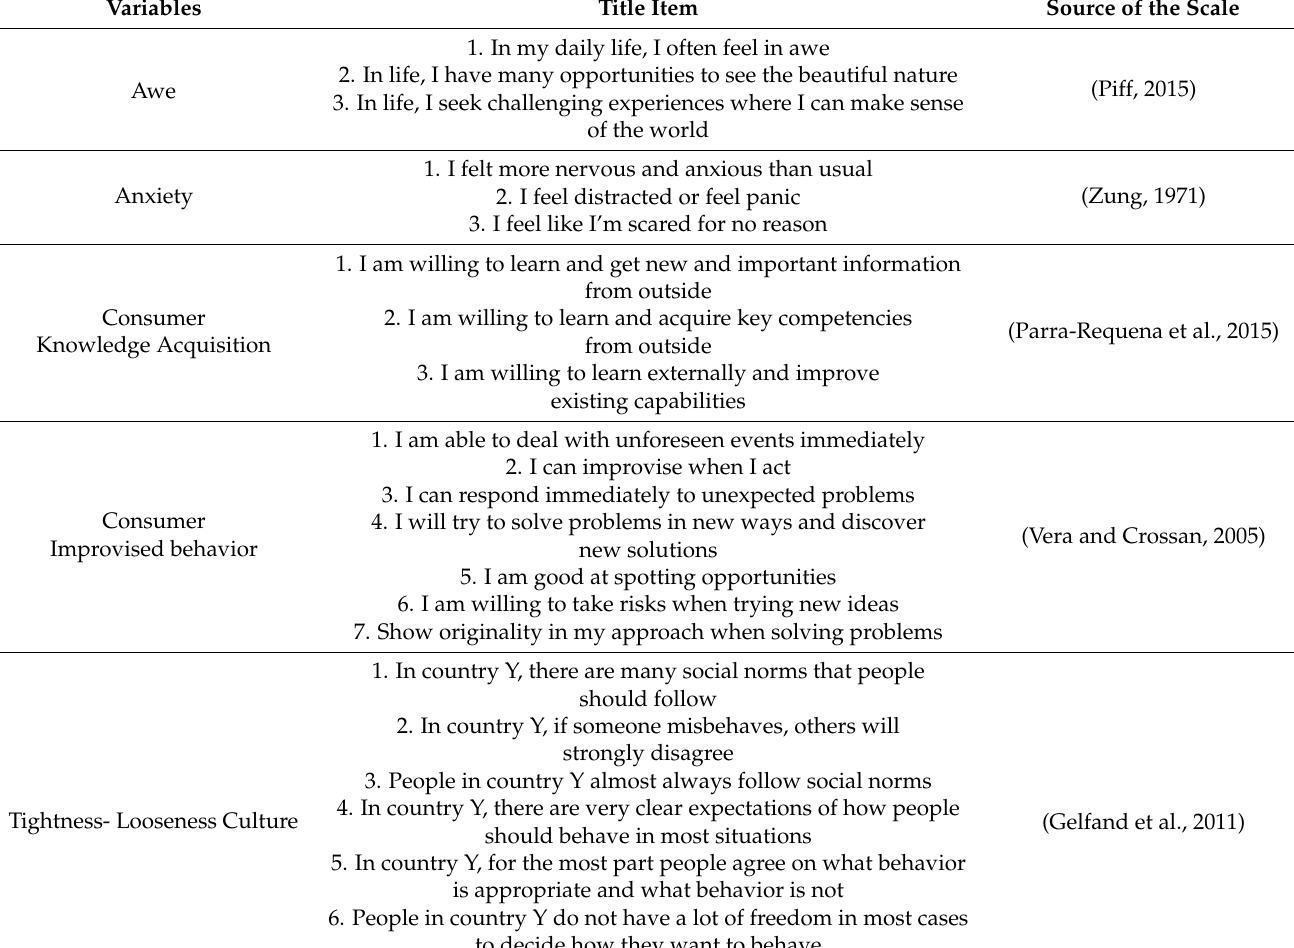
Table 1. Scale of measured